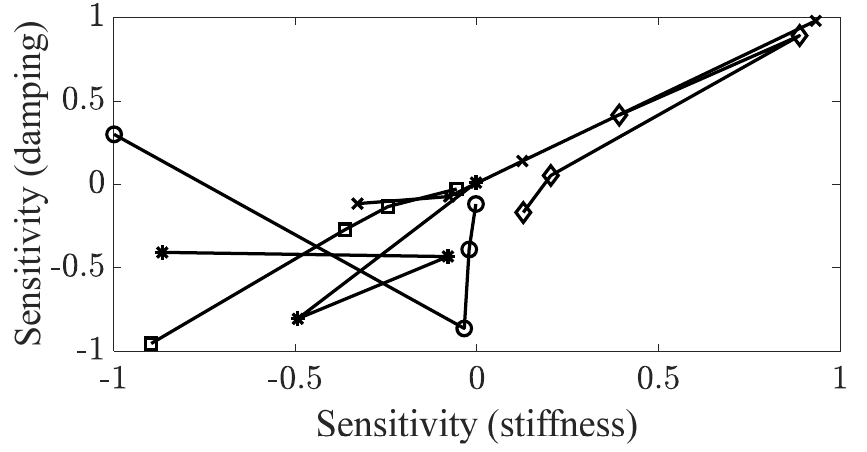
Figure 8. Sensitivity index comparison of equivalent parameters between the structural stiffness and